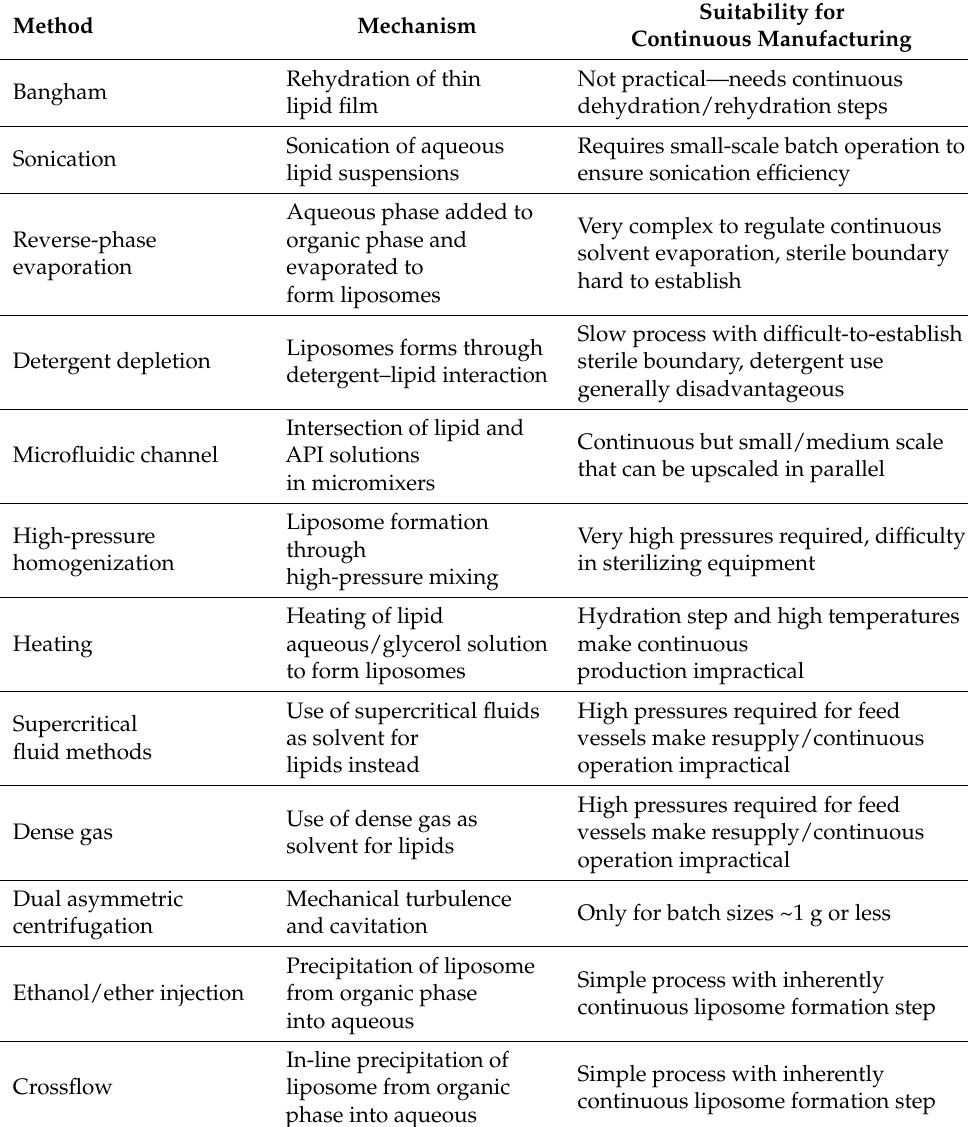
Table 2. Summary of liposome preparation methods and their suitability for continuous manufactur- ing Reprinted/adapted with permission from [117] and used under the Creative Commons license permission (CC BY 4.0). Copyright 2018, John Wiley & Sons, Inc. All rights